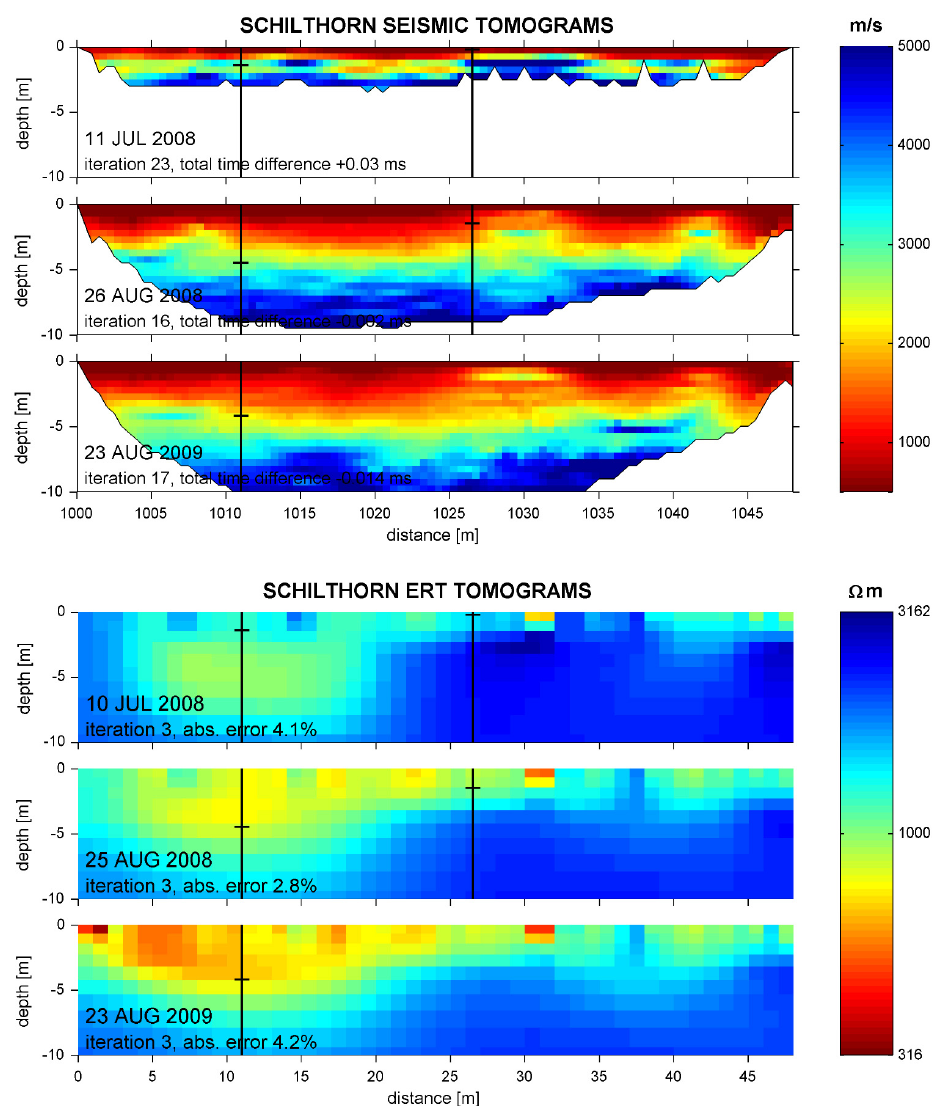
Fig. 10. Comparison of seismic and ERT tomograms for 11 July 2008, 26 August 2008, and 23 August 2009 at Schilthorn. Locations of the boreholes and the respective thaw depth are